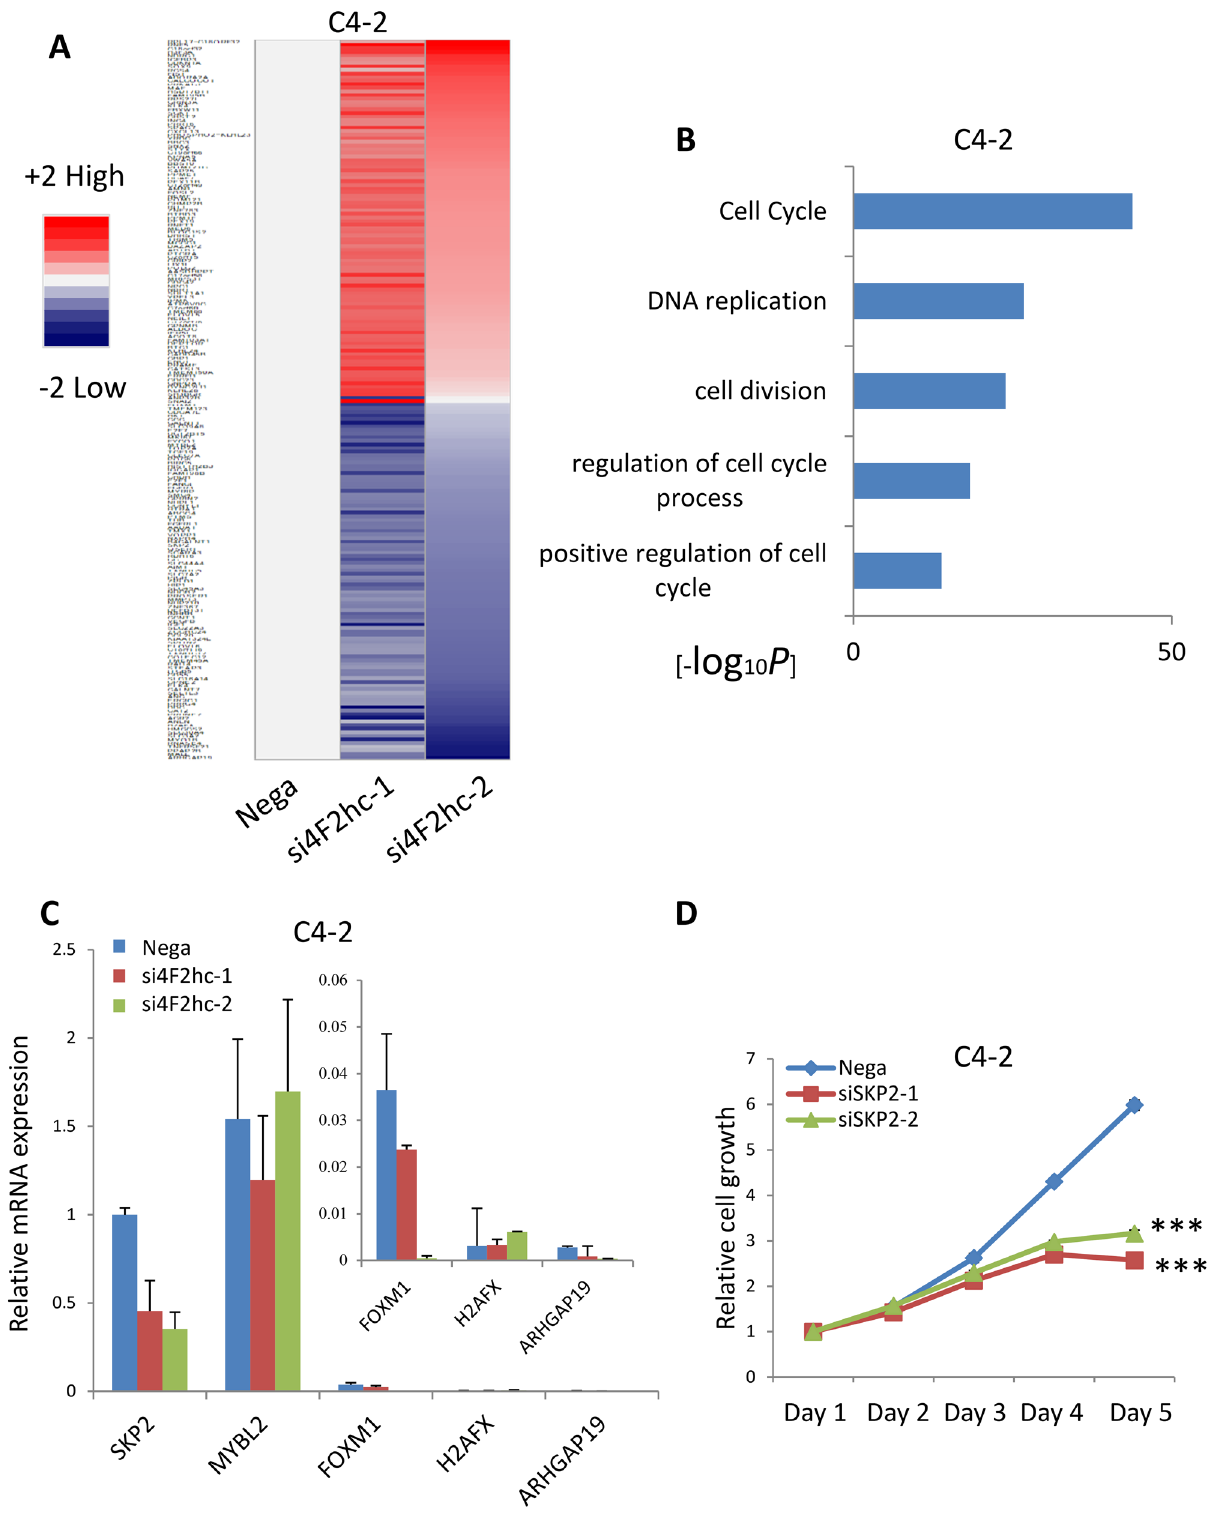
Figure 3. 4F2hc RNA-sequencing analysis. RNA-seq analysis was performed with si4F2hc (si4F2hc-1 and si4F2hc-2) and compared with a control group ( A ). The most down-regulated 1403 genes are selected, and Matascape is used for analysis of significantly related with GO terms ( B ). Si4F2hc concentration-dependent effect on candidate genes was assessed by real-time PCR ( C ). SiSKP2 (siSKP2-1 and siSKP2-2) inhibits C4-2 cell proliferation ( D ). Data represent three independent experiments with similar results. P-values were calculated by the Mann–Whitney U-test. *** p <